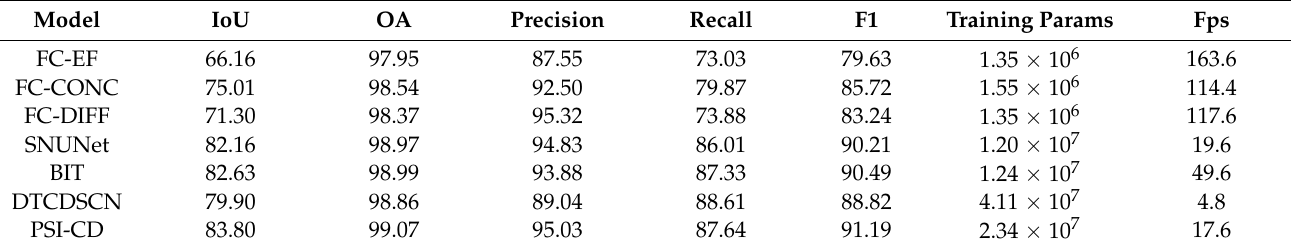
Table 2. Comparison of change detection results on LEVIR dataset (unit: